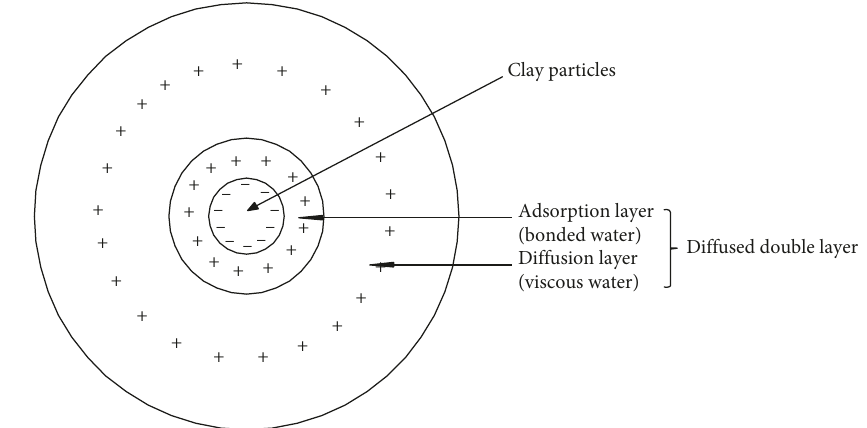
Figure 4: Double-layer structure diagram of clay particle.